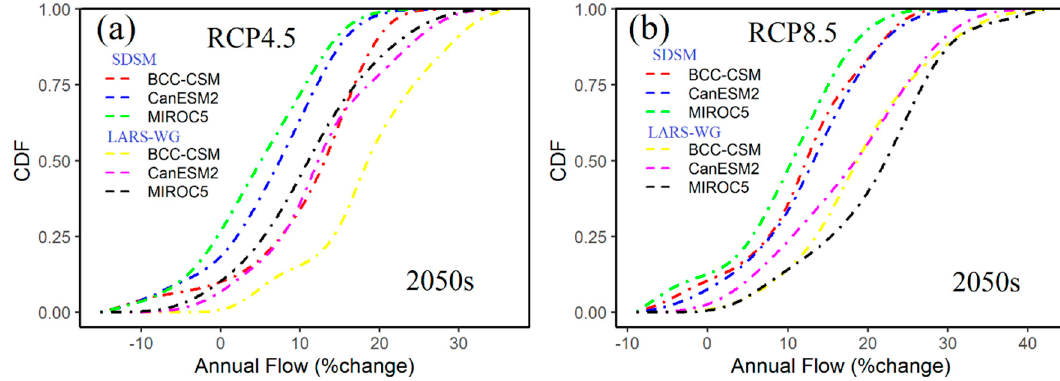
Table A2. Model performance rating based on Moriasi et al. [33].